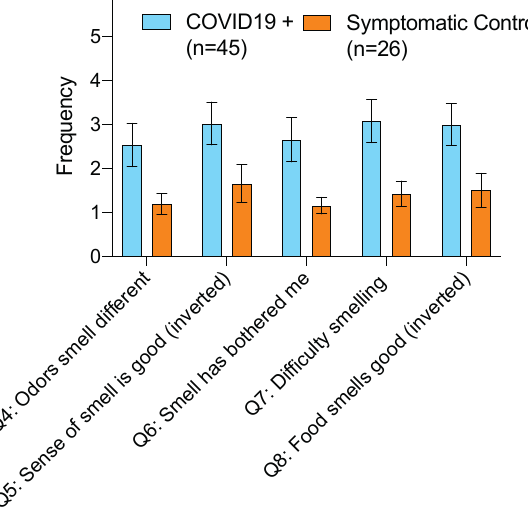
Figure S1. Nasal Symptoms were Similar Between COVID-19 + Patients and Symptomatic Controls at Baseline Indicating Comparable Illness Severity Between Groups. There was no significant difference in self- reported nasal symptoms between COVID-19+ patients (blue) and symptomatic controls (orange). Error bars represent 95% confidence intervals. Questions are answered on a 5-point Likert scale, (1=never, 2=rarely, 3=sometimes, 4=often, 5=always). Q1: Nasal/facial pain has bothered me. Q2: I have had nasal congestion. Q3: I have had nasal drainage.